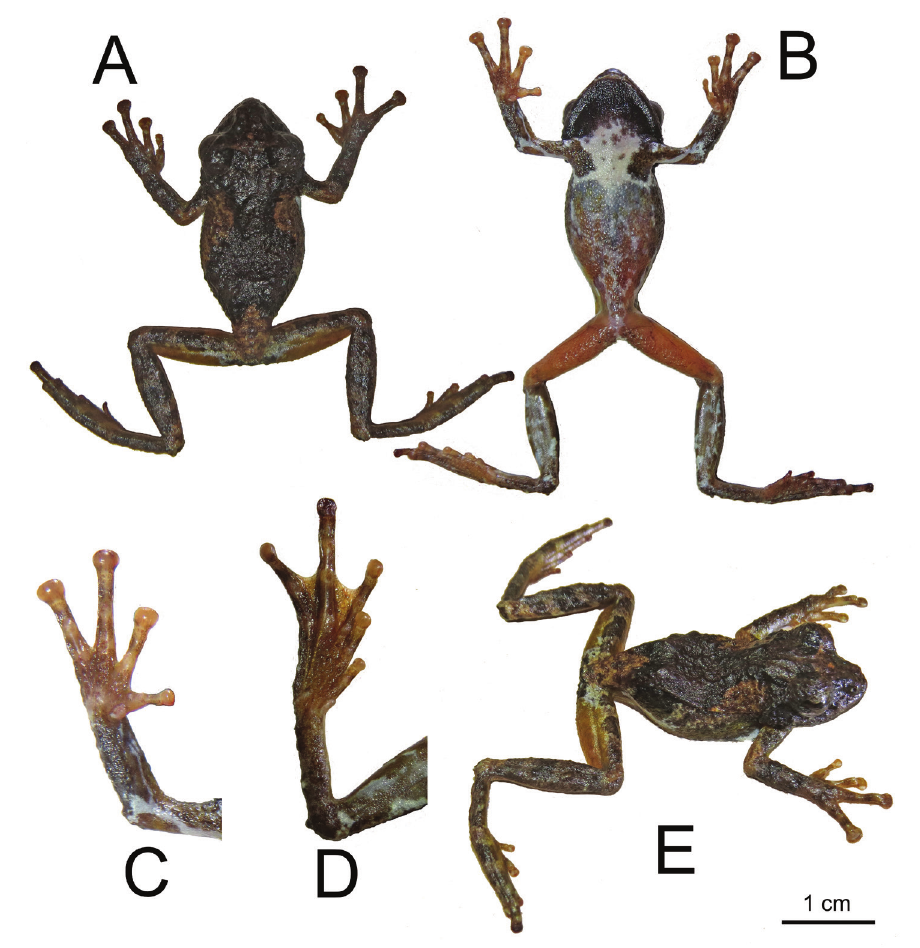
Figure 9. Holotype of Kurixalus inexpectatus sp. nov. A dorsal view B ventral view C right hand, ventral view D right foot, ventral view E dorsolateral